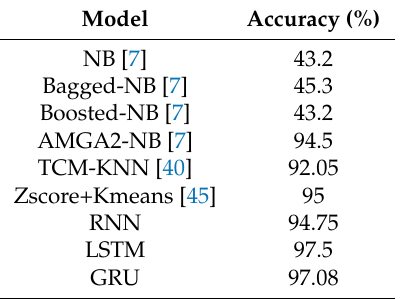
Table 9. Comparison accuracy detection results on ISCX